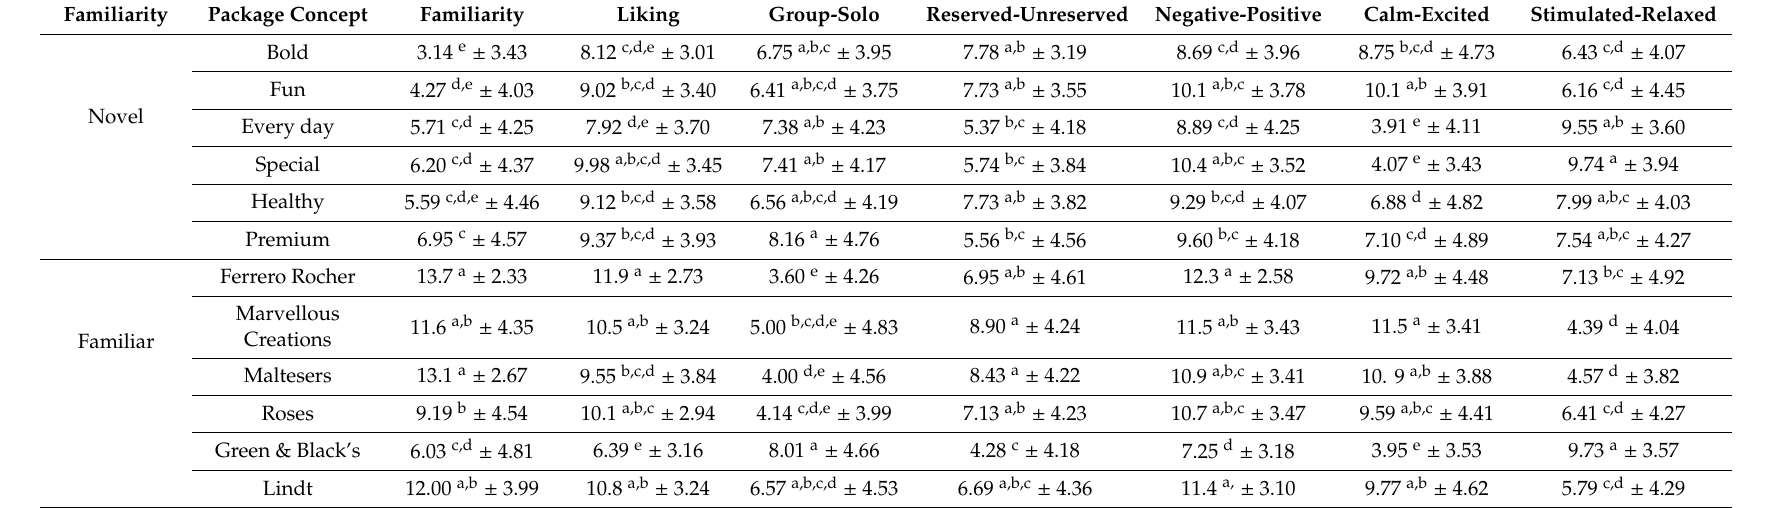
Table 3. Mean values (top) and standard deviation (bottom) of self-reported responses for novel and familiar packaging